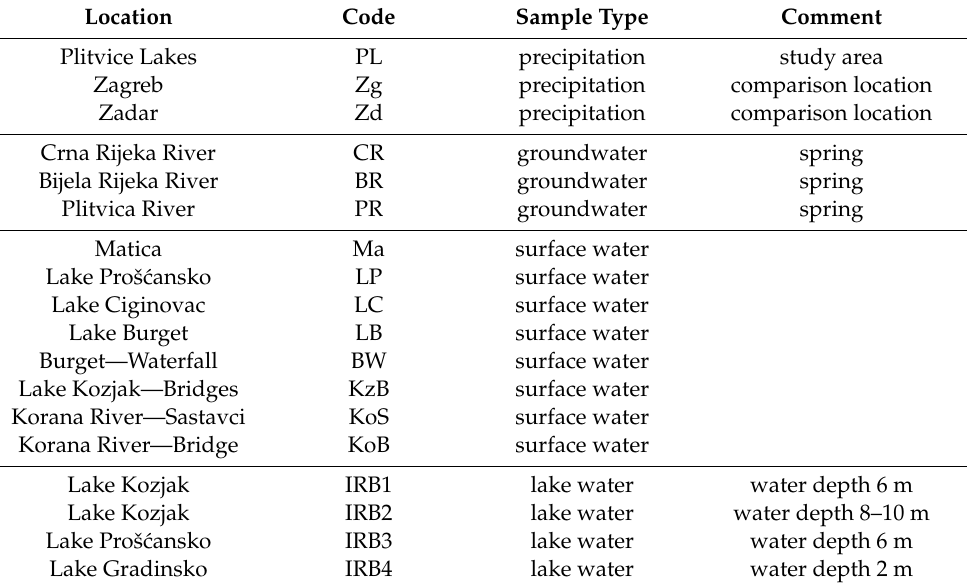
Table 1. List of sampling locations, their codes, and the types of water body samples. Location Code Sample